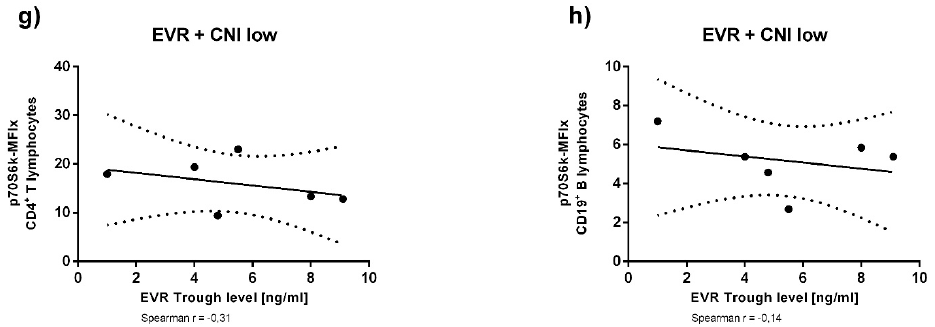
Figure A1. EVR trough levels did not correlate with p70S6k phosphorylation as measured in ( a ) CD4 + T lymphocytes and ( b ) CD19 + B lymphocytes when analyzing all patients receiving EVR. In the analysis of the small subgroup of patients ( n = 4) receiving EVR without a CNI a statistically significant positive correlation was found in both ( c ) CD4 + T lymphocytes and ( d ) CD19 + B lymphocytes. However, in the subgroup receiving a combination of EVR and a CNI again no significant correlation between trough levels of EVR and p70S6k phosphorylation could be found in both ( e ) CD4 + T lymphocytes and ( f ) CD19 + B lymphocytes. Patients with a combination therapy of EVR and TAC with a particularly low TAC trough level (< 5 ng/mL) showed no correlation of EVR trough levels with p70S6k phosphorylation found in both ( g ) CD4 + T lymphocytes and ( h ) CD19 + B lymphocytes, similarly to the rest of the subgroup with a combination therapy (* meaning p < 0.05).